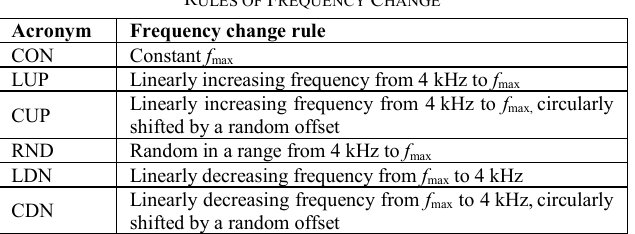
TABLE III R ULES OF F REQUENCY C